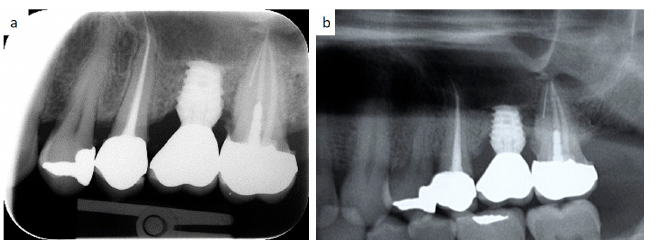
Figure 7. Periapical radiograms showing the bone loss at a 2-year ( a ) and a 10-year follow-up ( b ) around a short spiral implant (6.25 × 4.2 mm in diameter) supporting a single metal–ceramic crown. Table 1. Values of peri-implant bone loss during follow-up. Peri-Implant Bone Loss Peri-Implant Bone Implants at the Second Surgery Loss Two Years